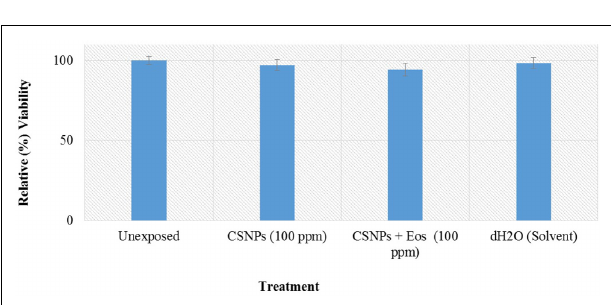
FIGURE 6 | Cytotoxicity analysis on Human corneal epithelial cells. Growth and survival of Human corneal epithelial cells was assessed by MTT [3-(4,5-Dimethylthiazol-2-yl)-2,5-Diphenyltetrazolium Bromide] assay.